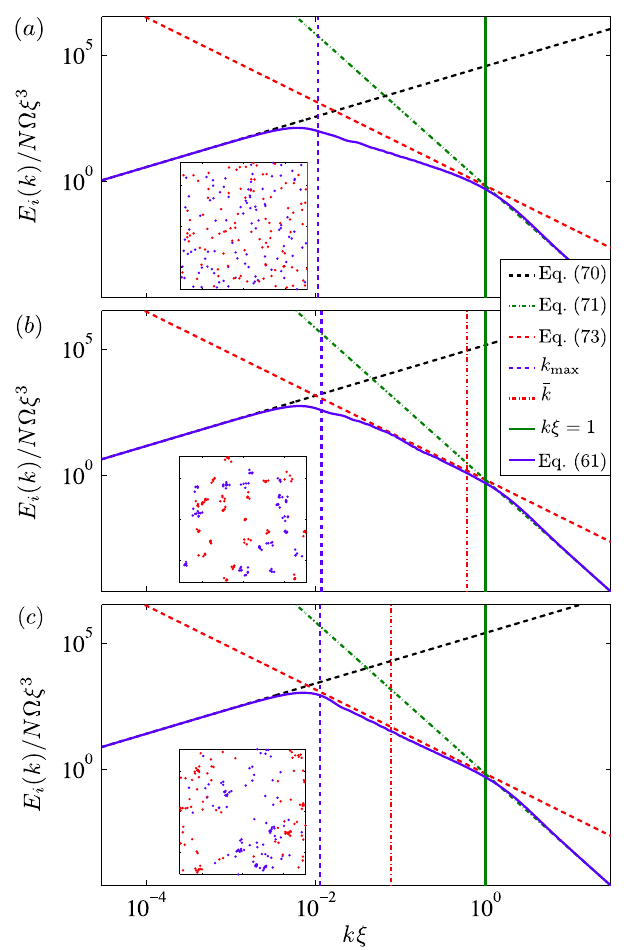
FIG. 5. Kinetic-energy spectra for N þ ¼ 100 and N (cid:2) ¼ 100 ¼ 100 samples (blue curves). The vortices, averaged over n s vortices are distributed (a) uniformly over the ð 600 (cid:1) Þ 2 square domain (inset), and clusters are sampled according to (81) and ¼ 5 vortices in each cluster, r ¼ (cid:1) , r ¼ (82), with (b) n c min max ¼ 20 vortices in each cluster and r ¼ 10 (cid:5)(cid:1) , and (c) n c max 100 (cid:5)(cid:1) , with each cluster center uniformly distributed over the periodic domain as in (a). The power-law sampling in panels (b) and (c) requires a radial exponent of (cid:5) (cid:7) ¼ 0 : 8 and 0.75, and gives a Kolmogorov k (cid:2) 5 = 3 region in the corresponding kinetic-energy spectrum of approximately 1 and 2 decades,